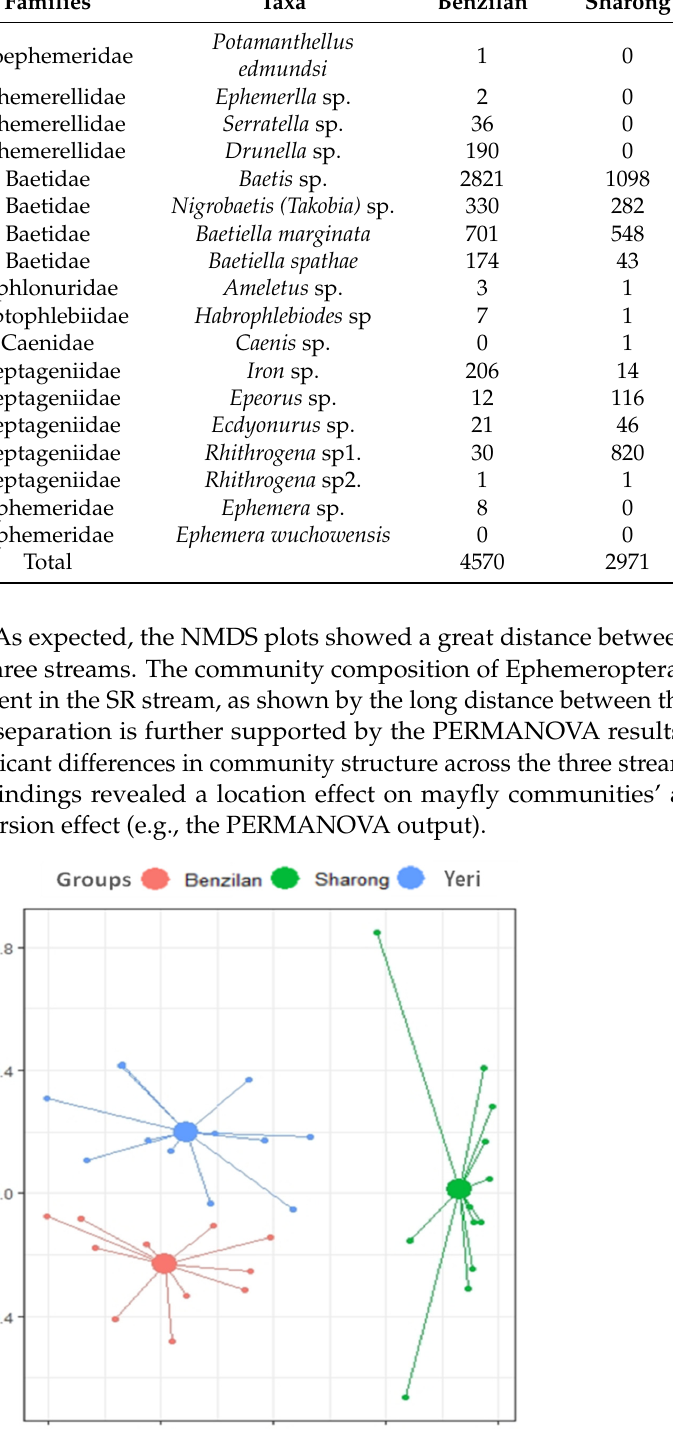
Table 2. Ephemeroptera taxa and their overall abundance and distribution in the three analyzed streams: Benzilan (BZL), Sharong (SR), and Yeri (YR).